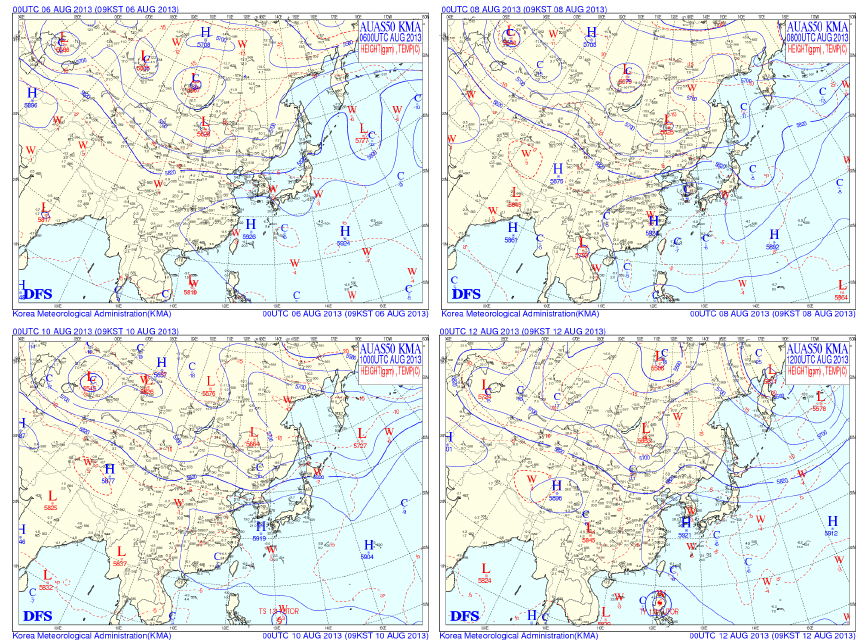
Figure 5. Weather charts at the 500hPa layer over the East Asia at 00:00 (UTC) on (a) 6 August, (b) 8 August, (c) 10 August and (d) 12 Au- gust 2013 (from Korea Meteorological